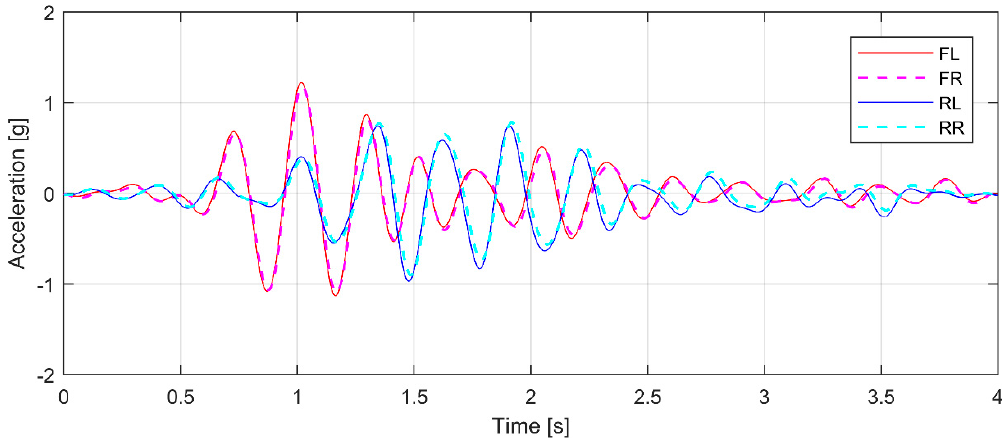
Figure 6. Spectrogram of the